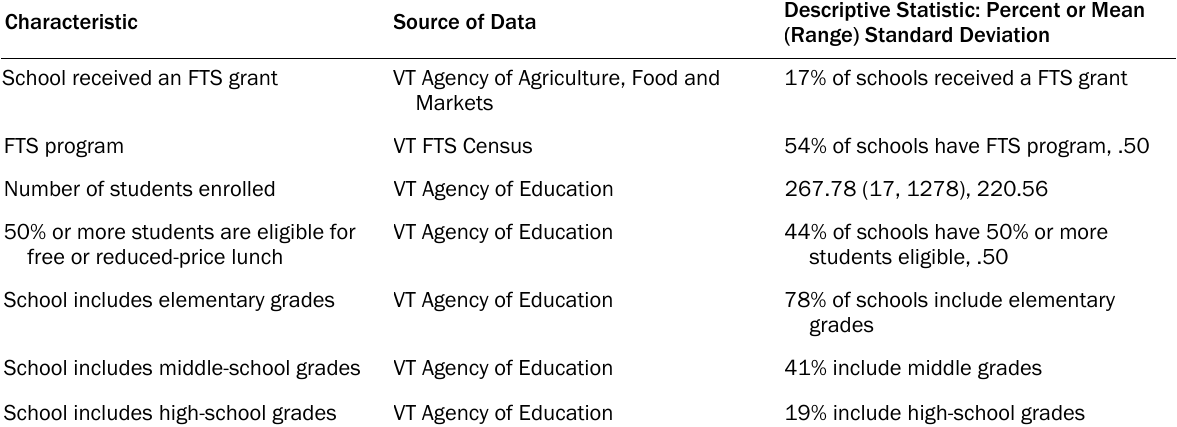
Table 2. Summary of Vermont School Demographic Information ( N =271) Characteristic